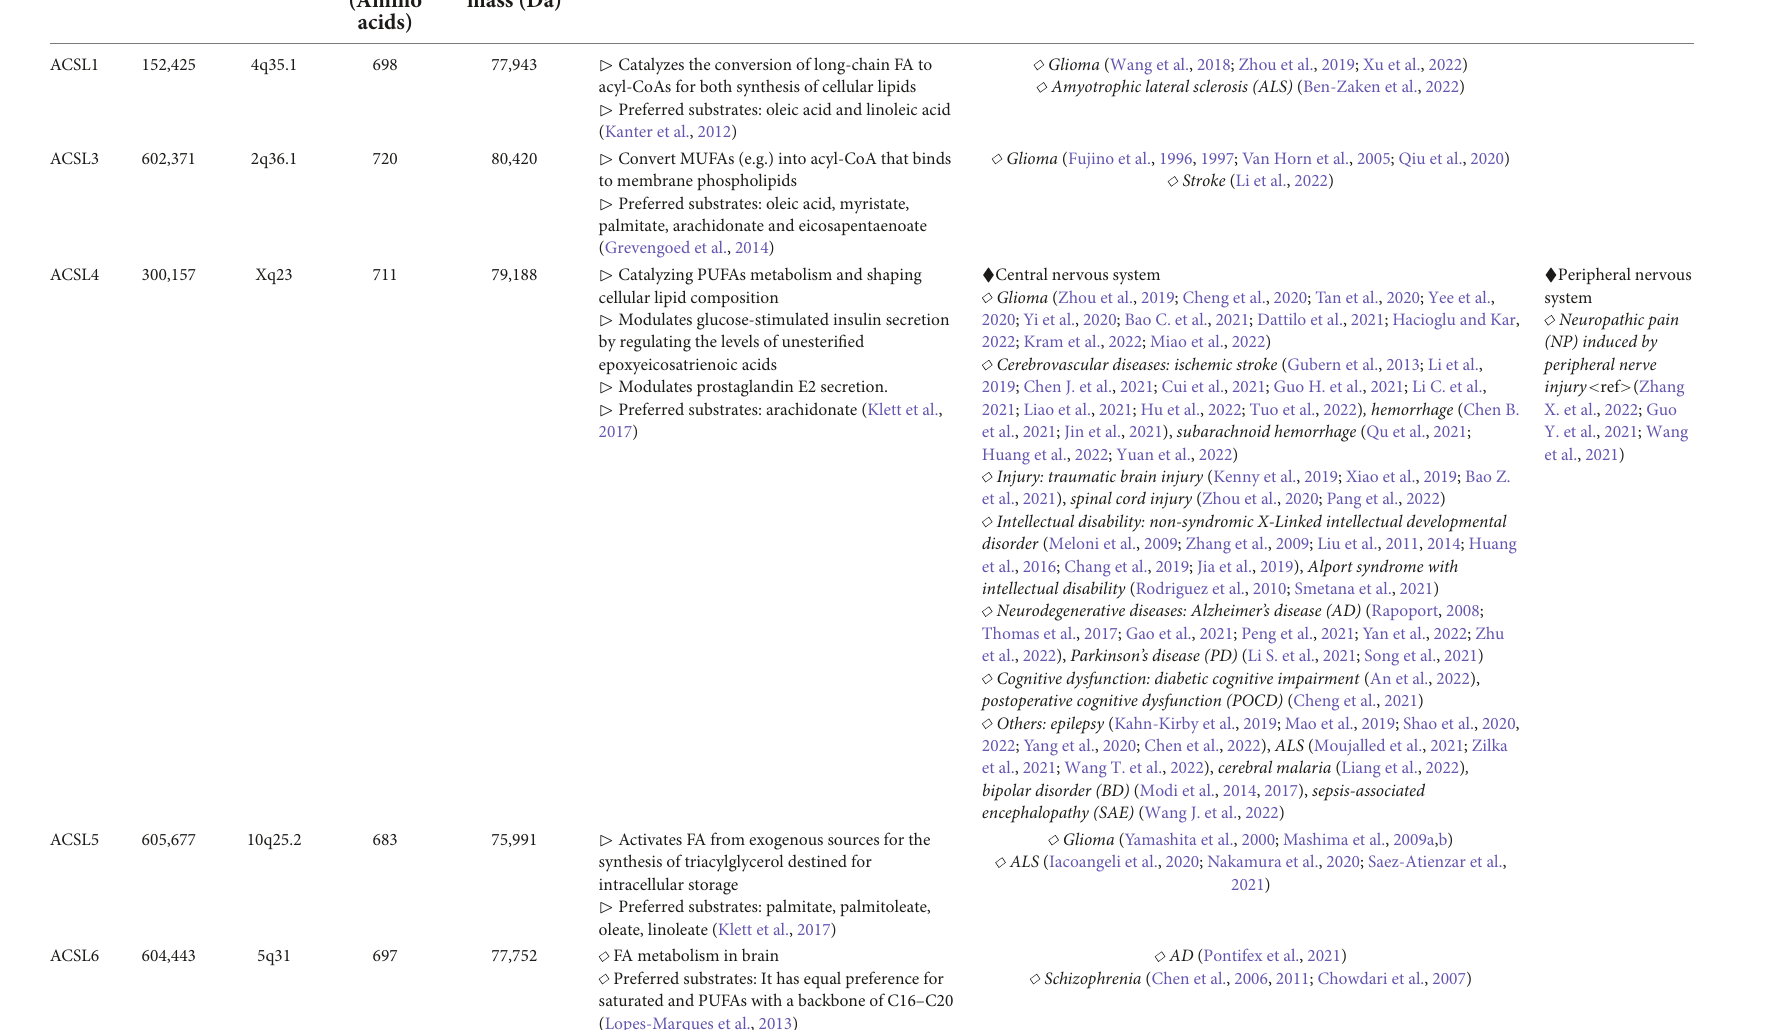
TABLE 1 Long-chain acyl-coenzyme A synthetases (ACSLs) and nervous system diseases (NSDs).